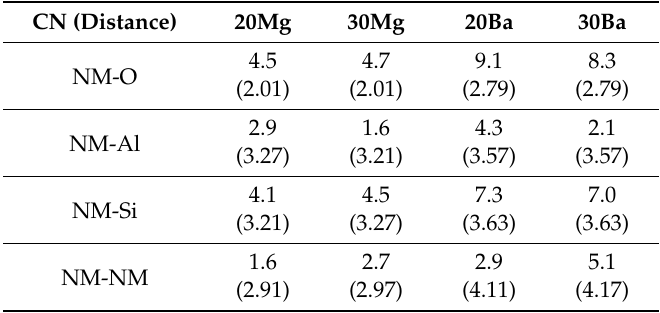
Table 3. Coordination numbers CN (and interatomic distances [Å]) of the network-modifier (NM) ions obtained for different chemical